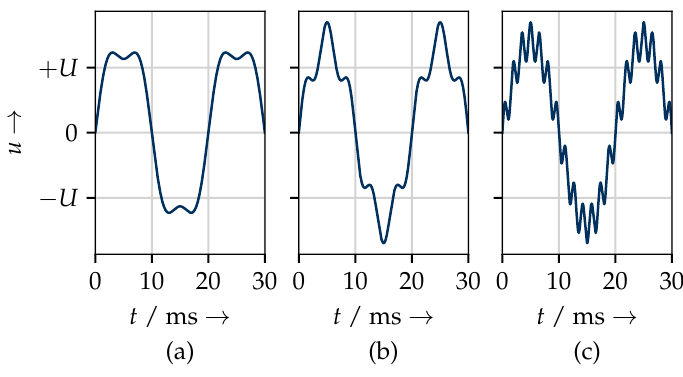
Figure 1. Harmonic distorted voltage waveforms with THD = 20%. ( a ) Third harmonic; ( b ) fifth harmonic; ( c ) 13th